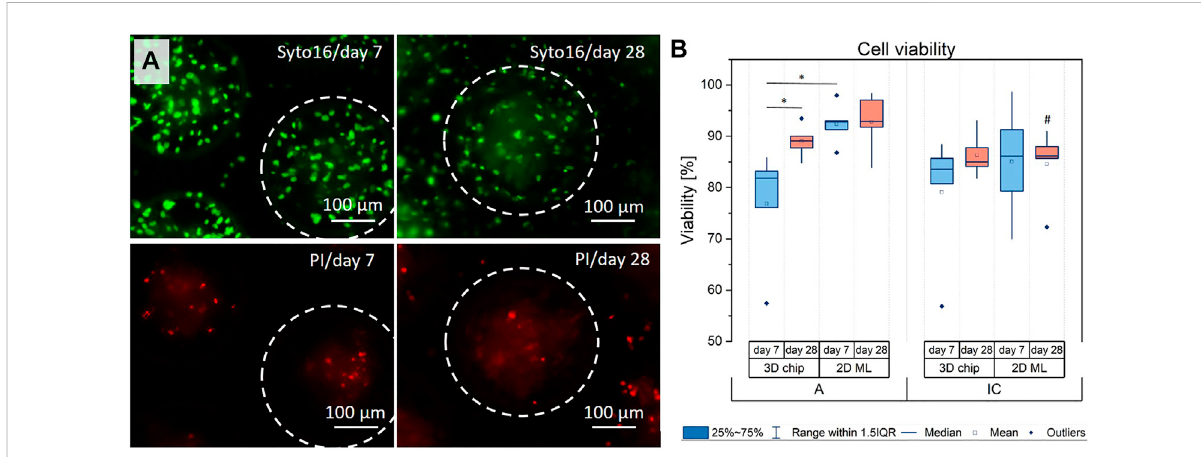
FIGURE 3 (A) Representative images of the live/dead staining of osteoblasts derived from alveolar bone (hOB-A) at days 7 and 28 in 3D-microchips under osteogenic conditions. The corresponding fl uorescence images of hOB-IC in 3D-microchips, and 2D monolayers of both cell types are provided in Figures S2 and S3. (B) For quantitative analysis of theviability fl uorescence images were analyzed by FIJI 2.1.0/1.53c software. Dotted circles indicate cell aggregates in one single microchip cavity. Syto16 (green fl uorescence): living cells; PI (red fl uorescence): dead cells. * p < 0.05 for comparison between culture types and time points; # p < 0.05 for comparison between hOB-A with hOB-IC at the corresponding time points and culture modes. Paired t -test, n =